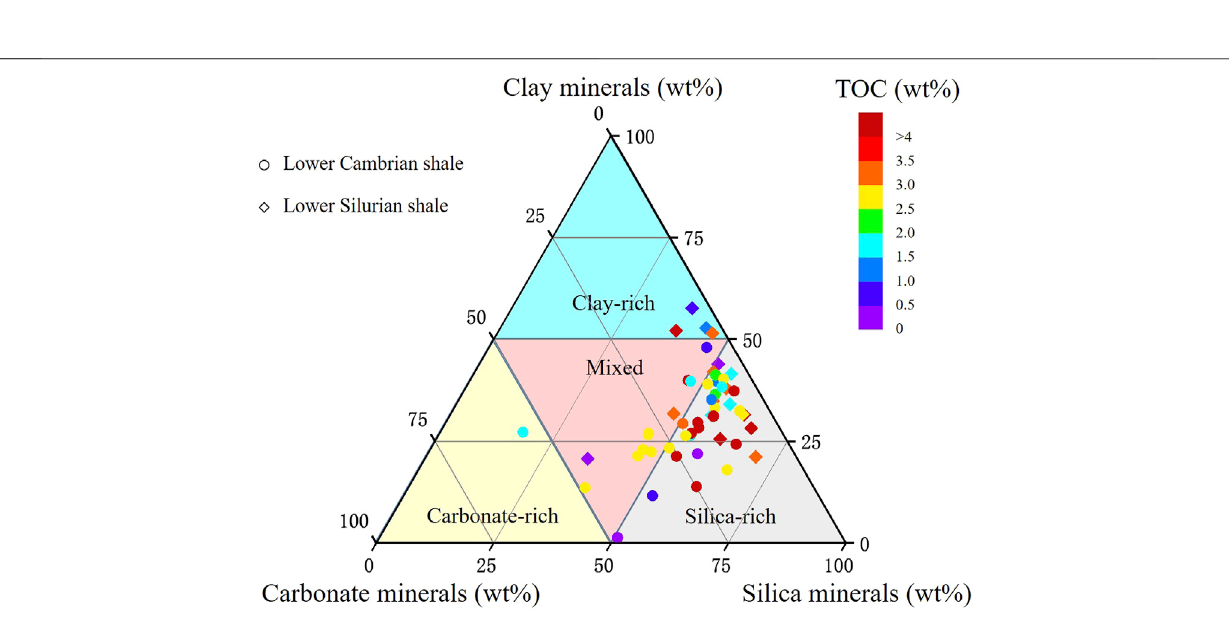
Frontiers in Earth Science |